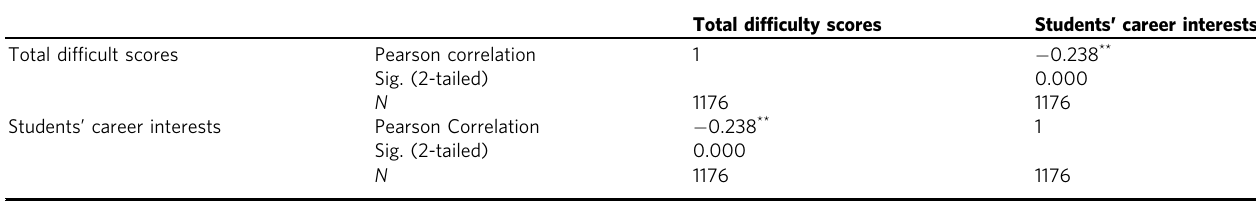
Table 2 Pearson correlation on the relationship between students ’ career interests and perceived concept dif fi culty in the study of computer science in Ghanaian and Nigerian Secondary